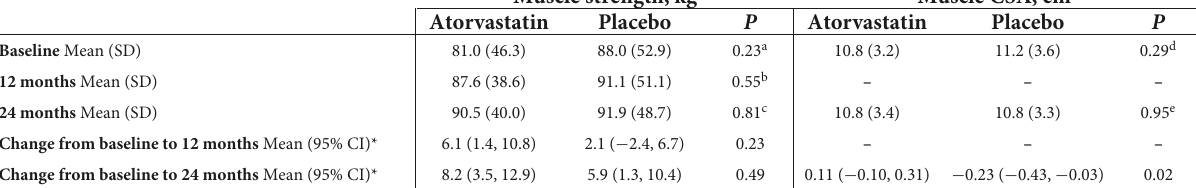
TABLE 3 Muscle strength and size over 2